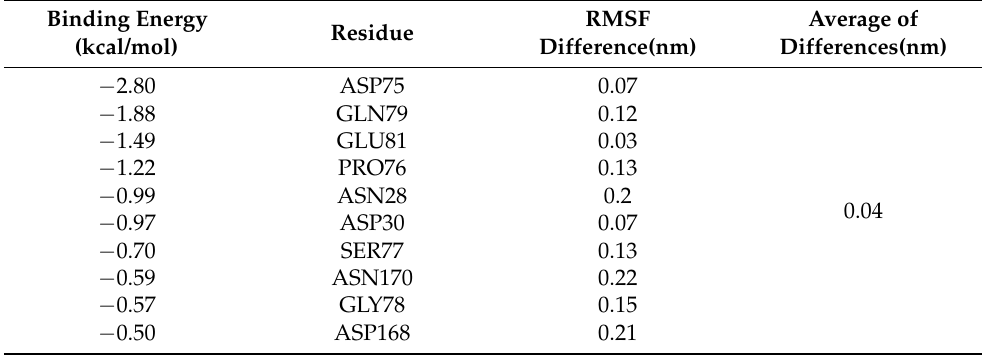
Table A4. shows the residues with binding energy contribution less than − 0.5 kcal/mol, and the corresponding RMSF differences, as well as the average of differences of all